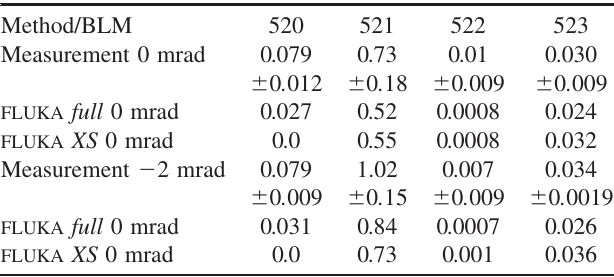
TABLE III. The measured and simulated BLM signals (in Gy = 10 10 lost particles) during 106.4 GeV 208 Pb 82 þ operation, as shown in the top part of Fig. 13.